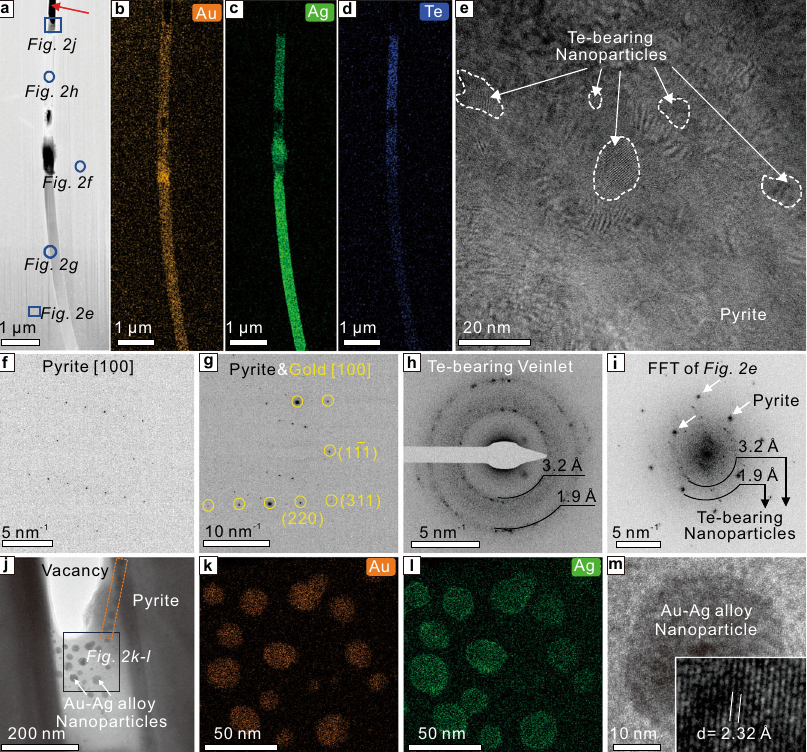
Fig. 2 TEM analyses of the gold-bearing pyrite from the Dakaitou deposit in Jiaodong gold province, China. High-angle annular dark- fi eld scanning transmission micrograph ( a ), energy disperse spectroscopic elemental maps ( b – d and k – l ), high-resolution transmission electron micrographs ( e , j , and m ), electron diffraction patterns ( f – i ) of the Dakaitou gold-bearing pyrite. The locations of the electron diffraction patterns and high-resolution transmission electron micrographs are marked in a . The elemental maps b – d location is the same as a . The location of the elemental maps k – l is marked in j . The red arrow in a indicates a vacant space in the fracture of pyrite.